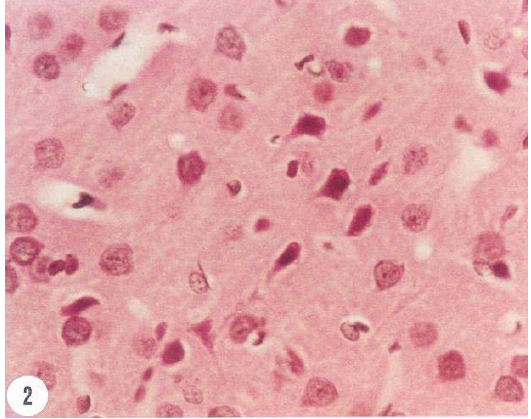
Figure 2. Cerebral cortex of a rat 72 hr after low dose envenoming showing normal neurons. Note increased number of neurons with round cytons, but a few polygonal cell bodies (H&E).